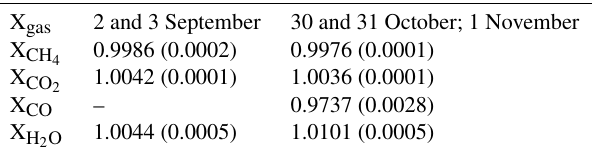
Table A1. Summary of correction factors from co-located EM27/SUN measurements with TCCON at CIT.